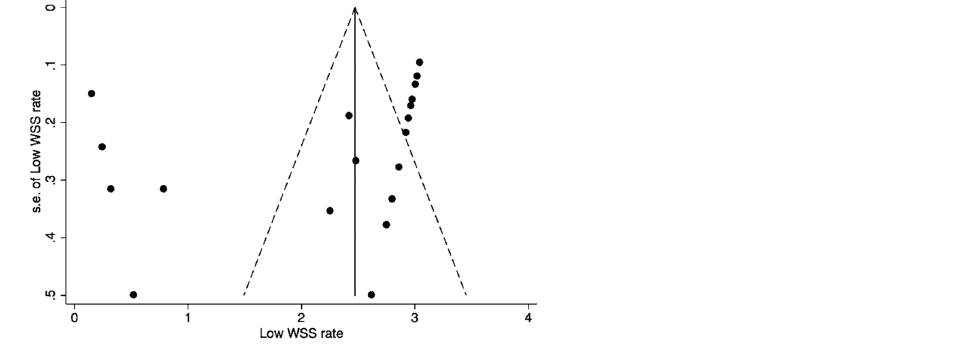
Figure 5. Funnel plot of the reported rate of low WSS.